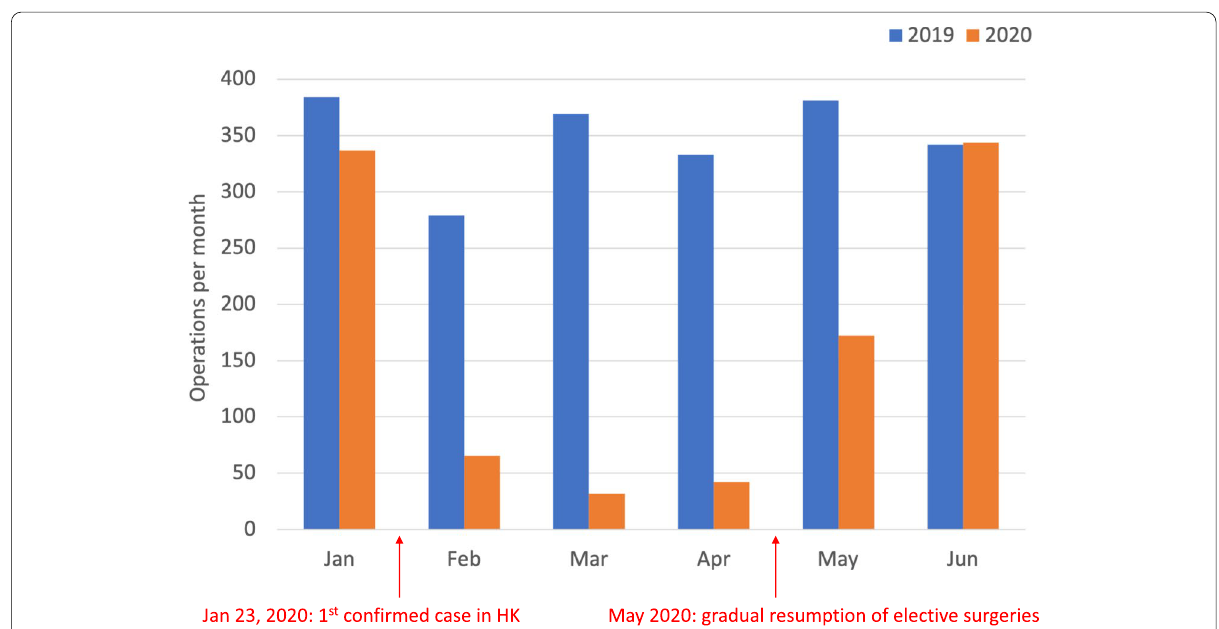
Fig. 1 Total surgical volume of elective hip and knee arthroplasties in Hong Kong (HK) public hospitals